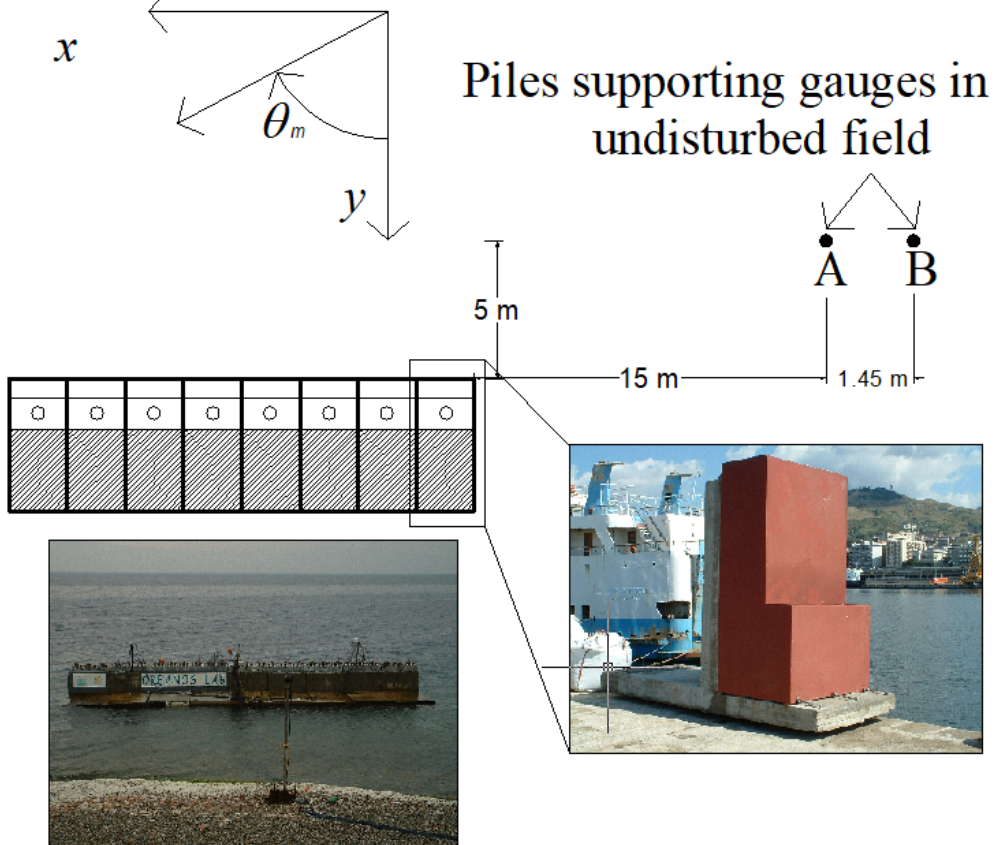
Figure 3. Layout of the experiment at sea.